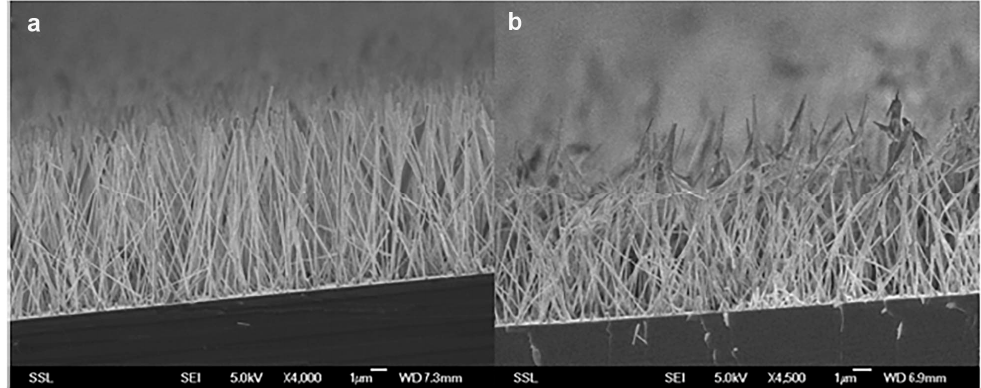
Figure 3 ( a ) 45° view. SEM image of ZnO nano-rods of about 20 µm aligned before the skin penetration Figure 3. ( a ) 45 ◦ view. SEM image of ZnO nano-rods of about 20 µ m aligned before the skin penetration studies; ( b ) 45° view. SEM image of ZnO nano-rods of 20 µm after the skin penetration. Vertical studies; ( b ) 45 ◦ view. SEM image of ZnO nano-rods of 20 µ m after the skin penetration. Vertical alignment is still visible, although the tips are slightly bent. alignment is still visible, although the tips are slightly